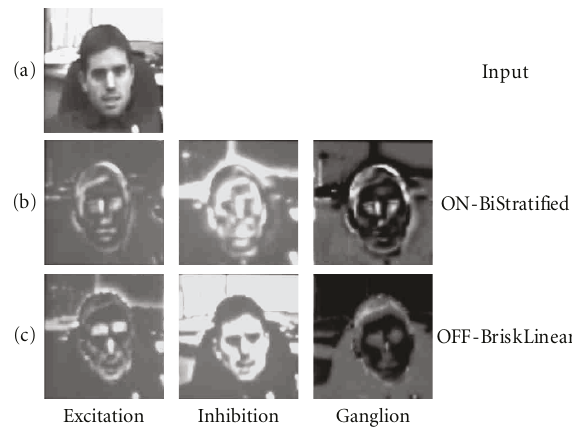
Figure 14: In this example two di ff erent (ON-, and OFF-type) retina channels are computed in video real-time by using our experimental